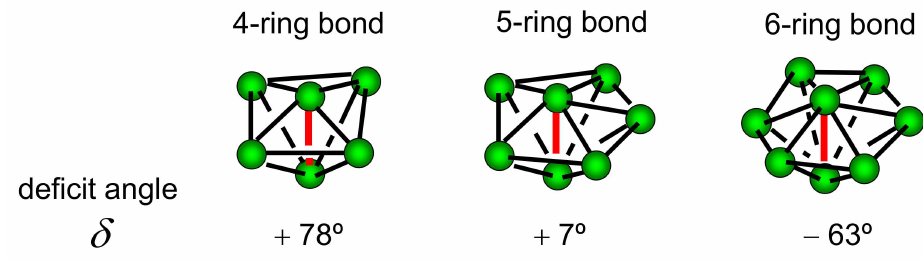
Figure 12. Schematics of the 4-, 5-, and 6-ring bonds and the deficit angle around each